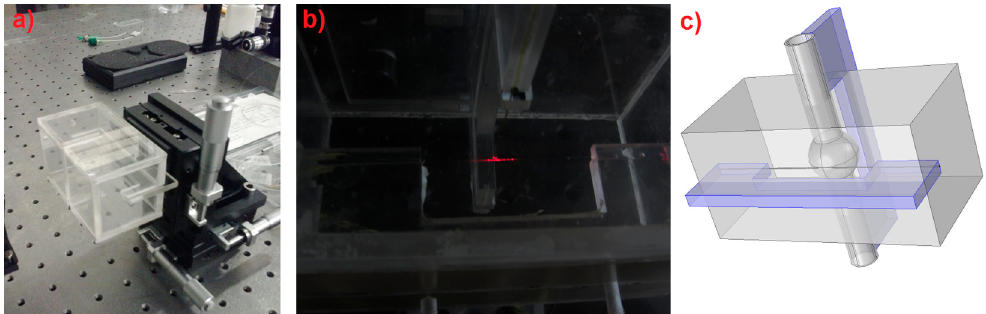
Figure 1. ( a ) Photo of the PMMA box that encloses the OMBR and the tapered fiber around the coupling area. Two orthogonal grooves allow the fine movements of the two C supports that are responsible to hold the resonator and the fiber. ( b ) Photo of the coupling area in which the taper and the OMBR are clearly visible due to scattered red light out of a diode laser. ( c ) 3D sketch of the box: two orthogonal holders (in violet) are used to allow the coupling between the OMBR and the tapered fiber.